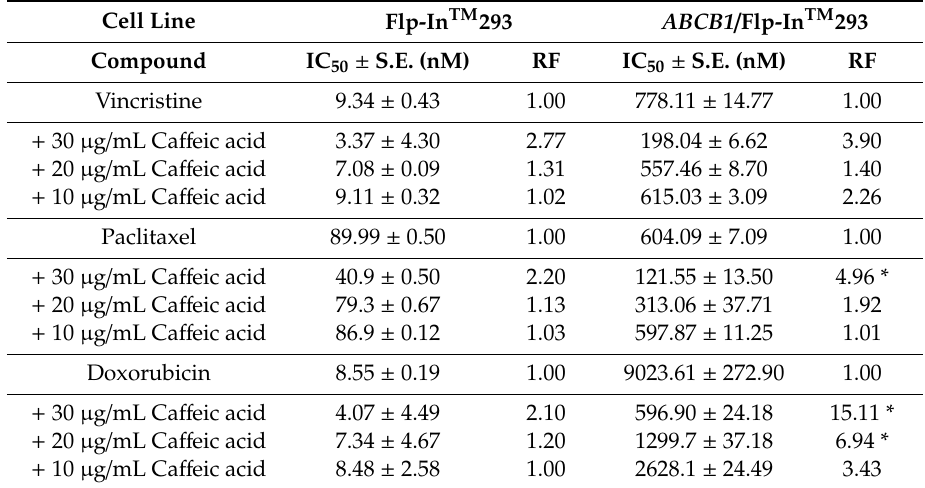
Table 2. The reversal e ff ects of ca ff eic acid on chemotherapeutic drug resistance in P-gp over-expressing cell line ABCB1 / Flp-In TM 293.